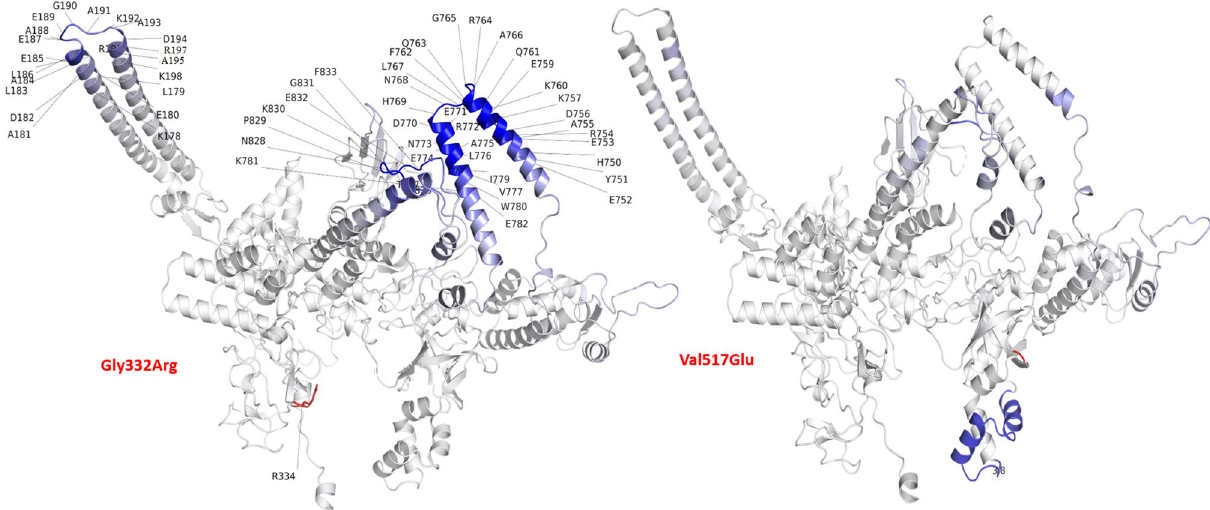
Figure 2. Effect of the rpoC G332R and V517E point mutations on RpoC protein dynamics. ΔΔG; Free energy difference. ΔΔS Vib ENCoM; vibrational entropy energy. The effects have been predicted through the DynaMut online server. The increasing (red) and decreasing (blue) molecular flexibility effects of point mutations have been depicted. The total energy calculated for mutations shows a stabilizing effect on protein